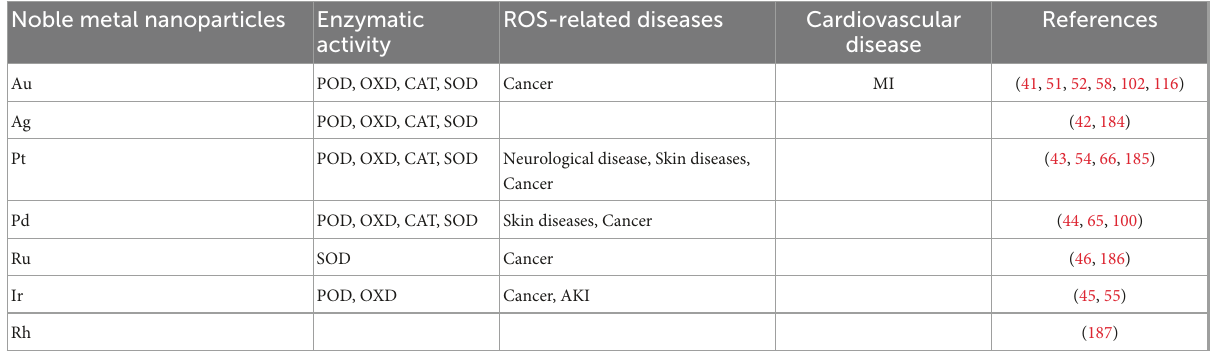
TABLE 1 The enzymatic mimetic activities of different precious metals and their specific therapeutic applications in several major ROS-related diseases and cardiovascular